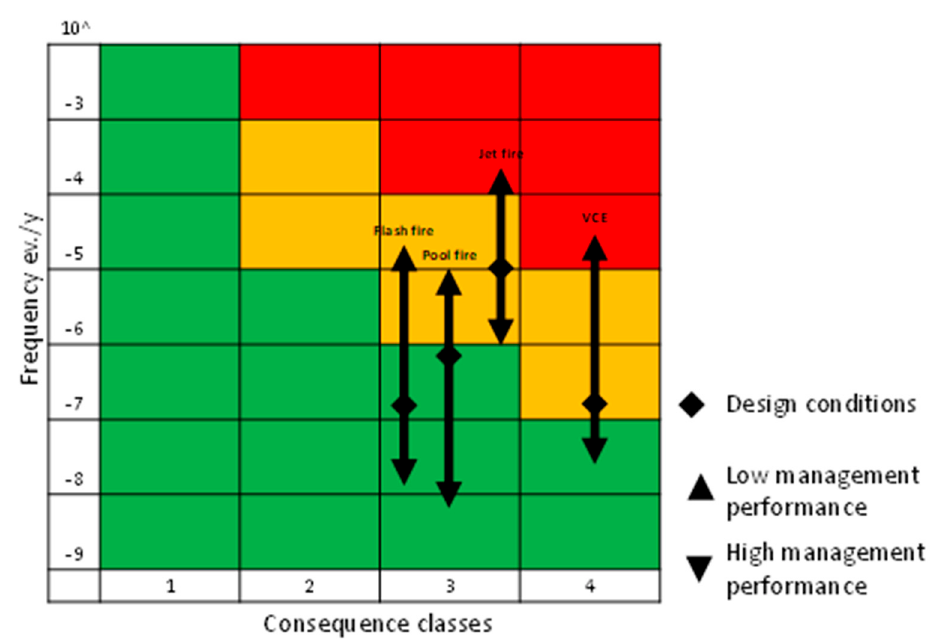
Figure 7. Risk Matrix for design conditions, high and low performances.